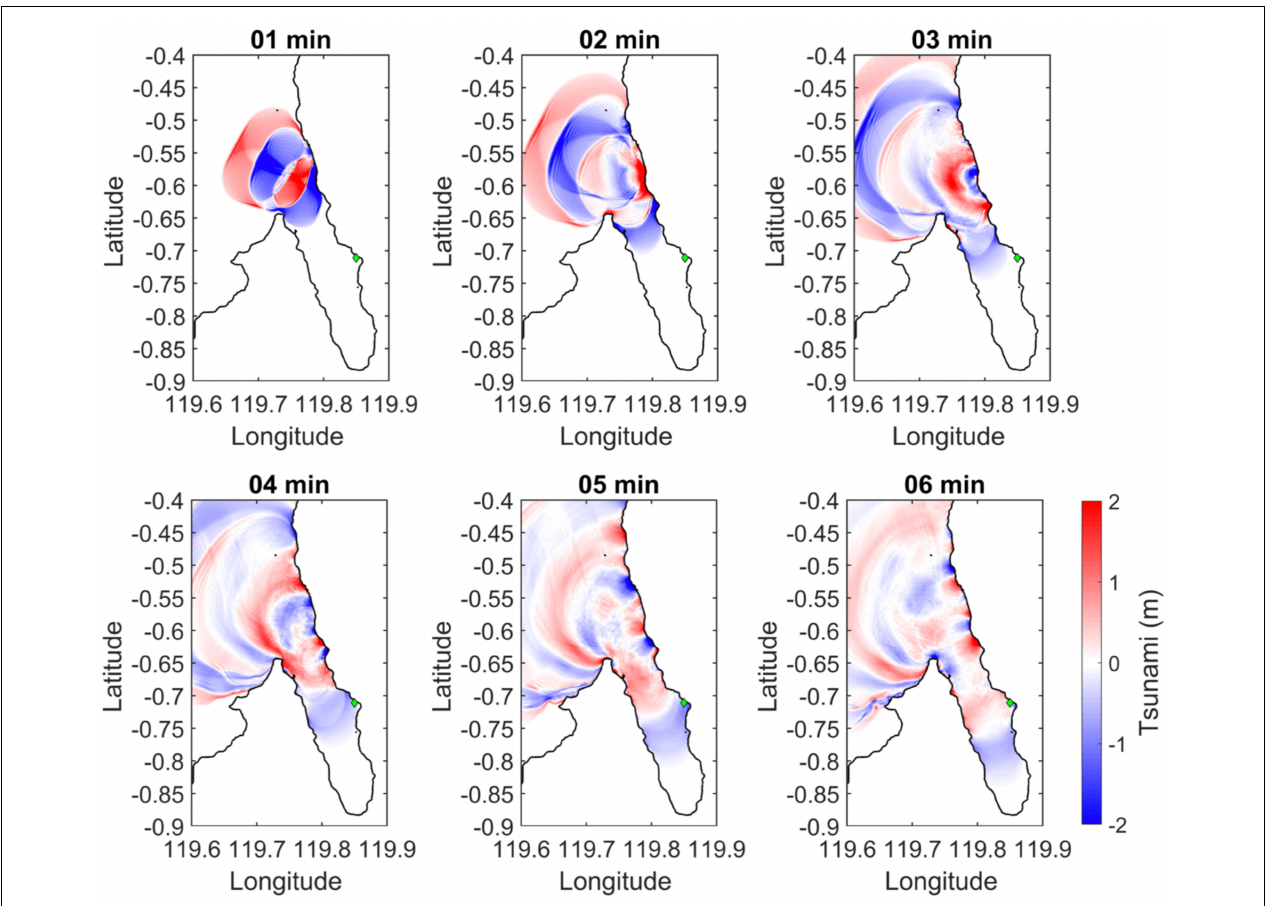
FIGURE 6 | The snapshots of the tsunami propagation. The color shading indicates the free surface elevation in meters. The green diamond indicates the location of Pantoloan. The time depicts the instants after the mainshock of the earthquake (10:02 UTC, September 28,